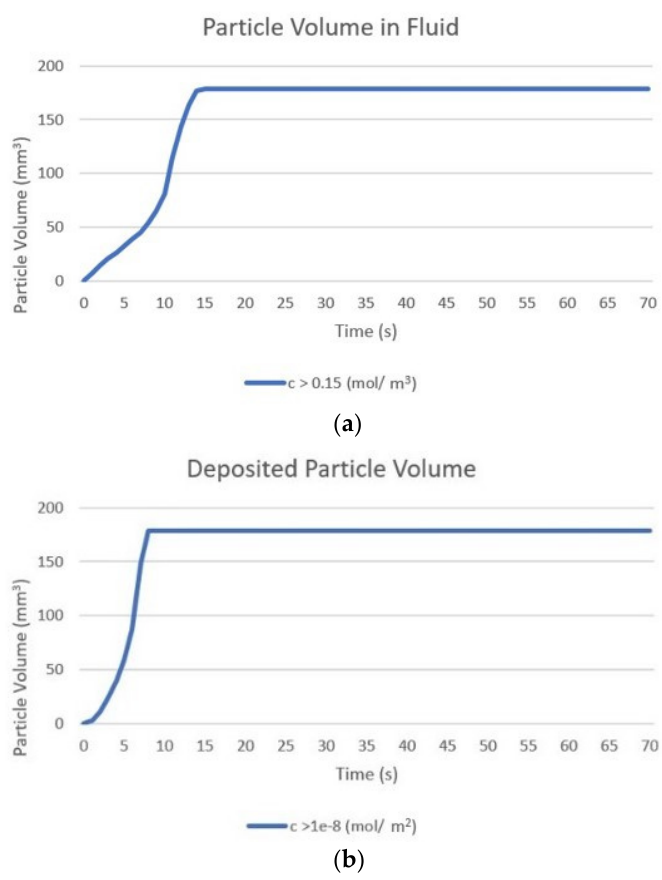
Figure 8. Change in the calculated volume of particles from the start of injection to 1 min post- injection particle. Particle volume is calculated as the sum of volumes where particle concentration is greater than the specified threshold: ( a ) volume within the fluid, threshold 0.15 mol/m 3 ; ( b ) deposited onto cell surfaces, threshold 1 × 10 − 8 mol/m 2 .